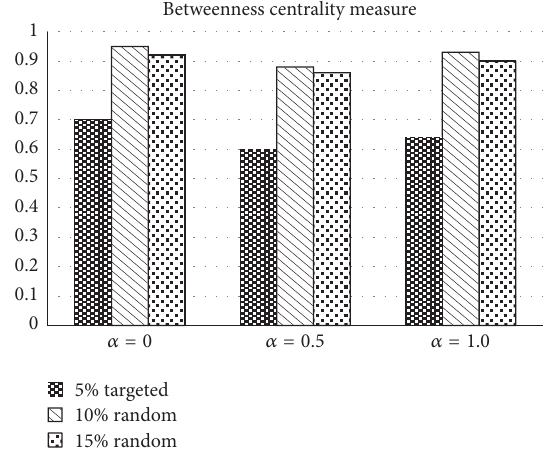
Table 1: Centrality scores of actual network.